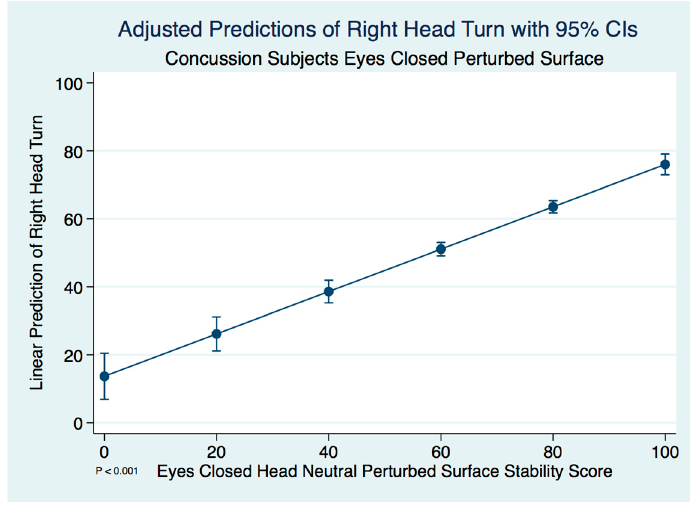
Figure 1. Adjusted predictions of right head turn stability scores in concussion subjects.